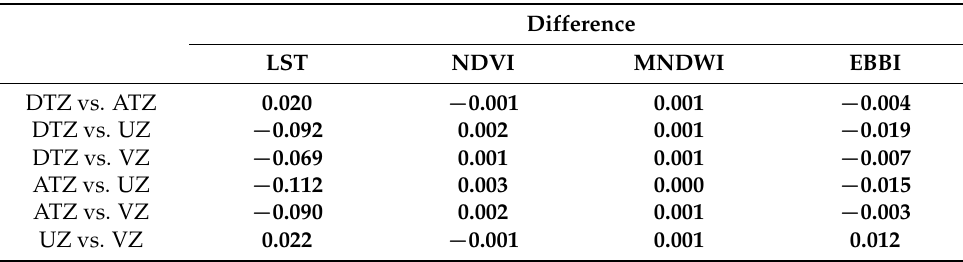
Table 9. Pair comparison of the average trend of 32-year changes in the LST, NDVI, MNDWI and EBBI indices in the zones based on Tukey (HSD) test (1987–2019). Difference LST NDVI MNDWI EBBI DTZ vs. ATZ 0.020 − 0.001 0.001 − 0.004 DTZ vs. UZ − 0.092 0.002 0.001 − 0.019 DTZ vs. VZ − 0.069 0.001 0.001 − 0.007 ATZ vs. UZ − 0.112 0.003 0.000 − 0.015 ATZ vs. VZ − 0.090 0.002 0.001 − 0.003 UZ vs. VZ 0.022 − 0.001 0.001